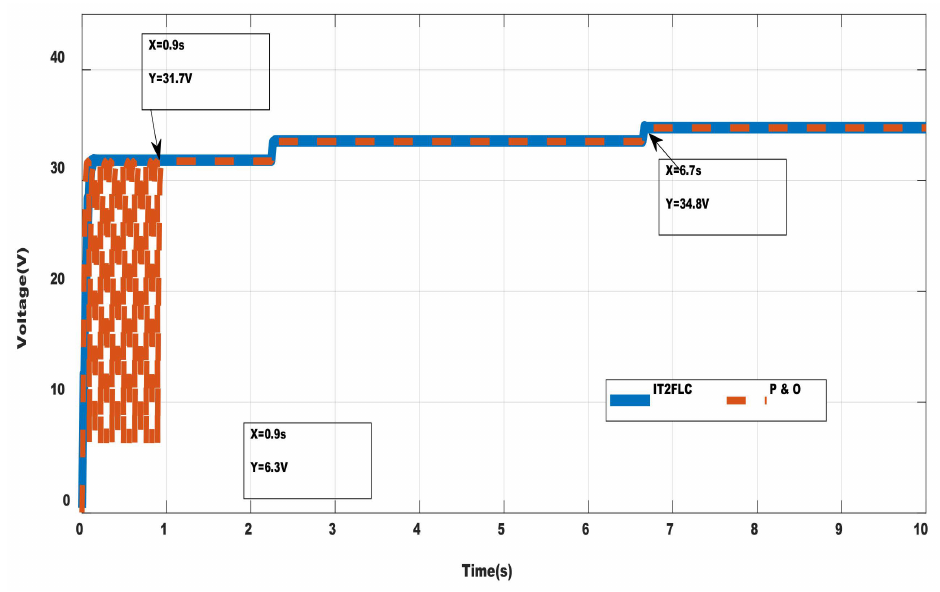
Figure 22. Voltage response for variable time.